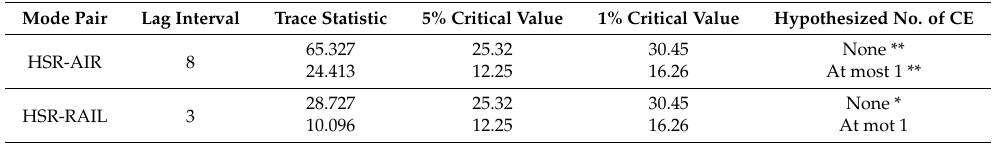
Table 4. Results of Johansen’s co-integration test.